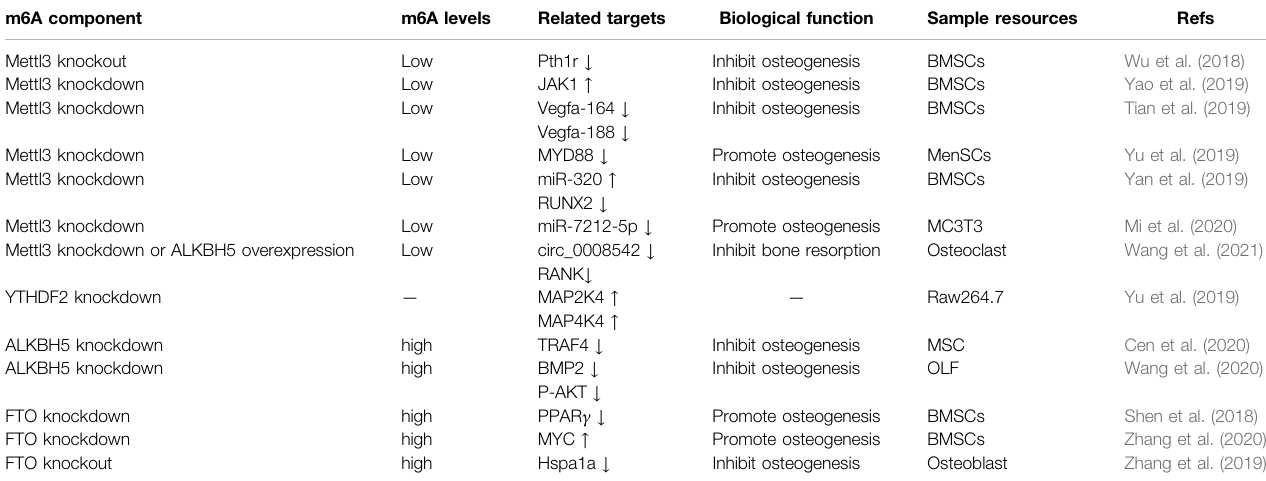
TABLE 1 | Multiple functions exerted by m6A RNA methylation in bone. m6A